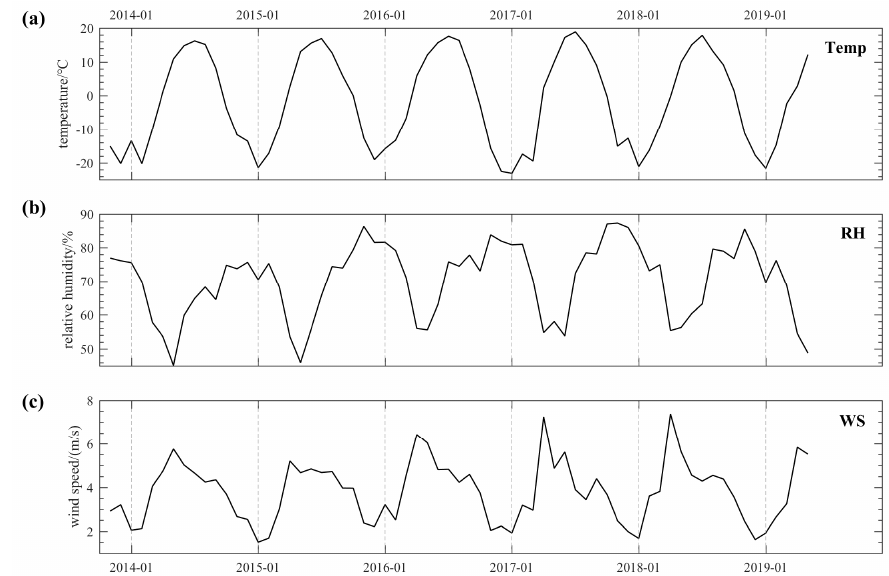
Figure 4. Monthly average variations of ( a ) temperature ( b ) relative humidity ( c ) wind speed from November 2013 to May 2019 (Temp — temperature; RH — relative humidity; WS — wind speed). Gray dashed lines represent January of each year.